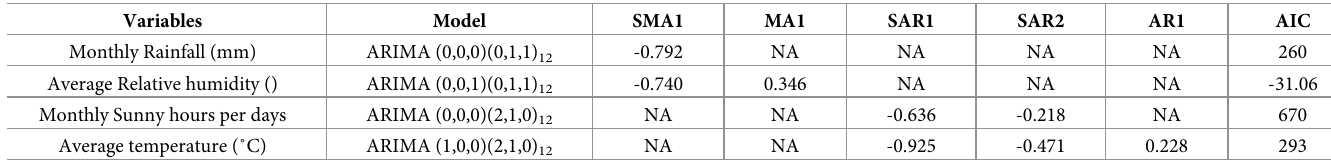
Table 2. Optimal models and parameter values for meteorological variables in Kerman province, Iran during 2014–2020. Variables Monthly Rainfall